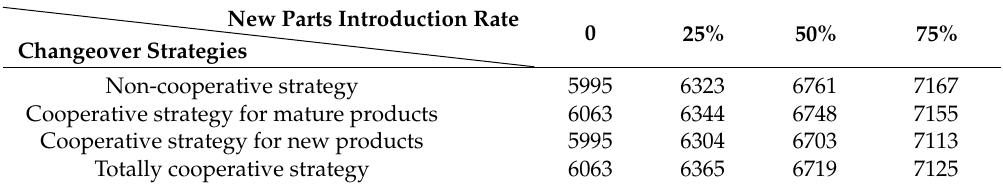
Table 8. Mean values of production cycles under different conditions (Unit: Min).